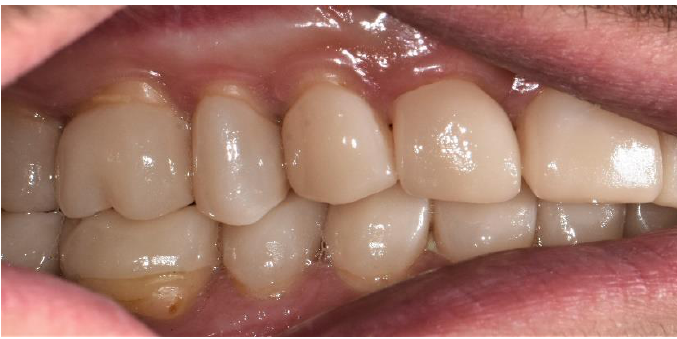
Figure 14. Final view of the right side.